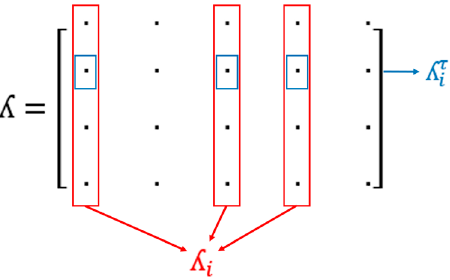
Figure 4. Truck to station assignment: general ( ʎ ), cluster ( ʎ (cid:3036) ), and chain of instructions ( ʎ (cid:3036)(cid:3099) ).